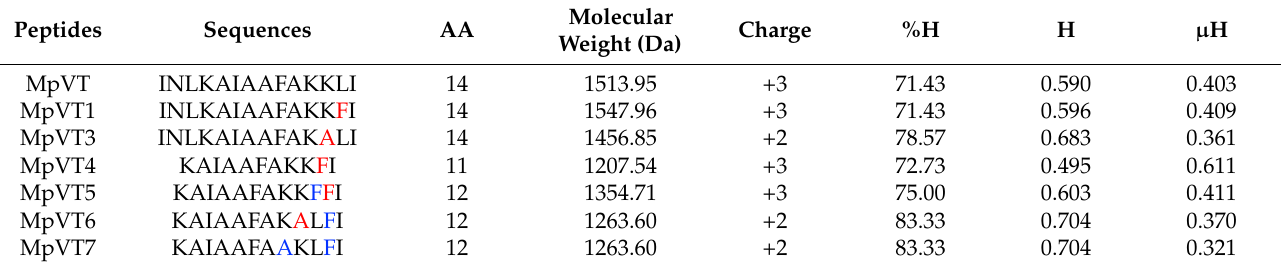
Table 1. The physicochemical prediction of the peptides.